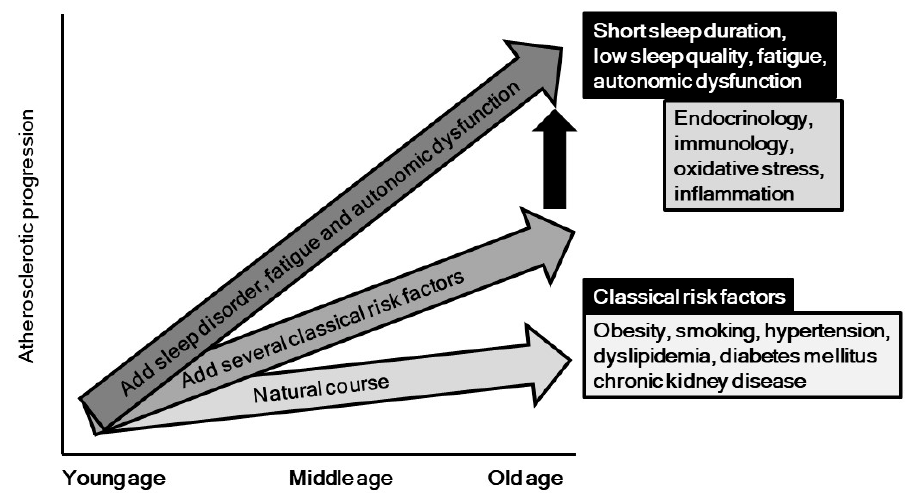
Figure 4. Potential impacts of psycho-behavior factors on progression of atherosclerosis. As shown in vertical black arrow, psycho-behavior factors might accelerate the degree of atherosclerotic progression, which is induced by classical risk factors such as diabetes, hypertension, obesity, and others.